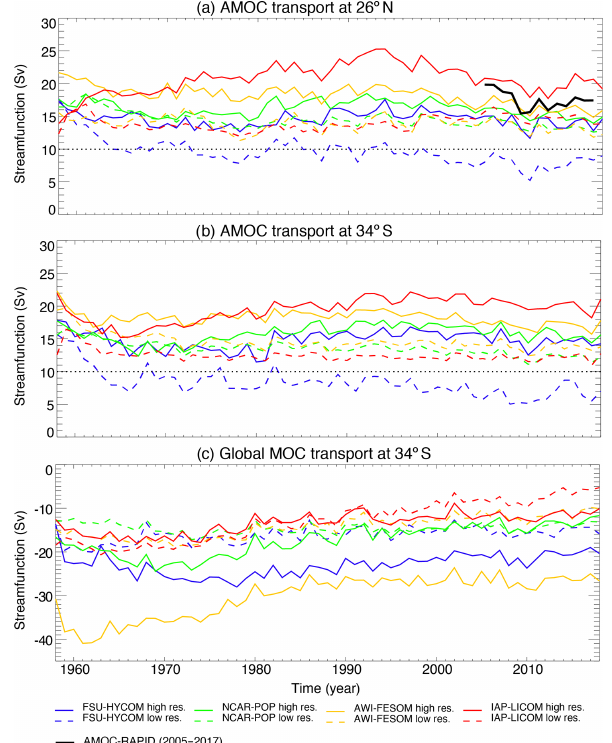
Figure 15. Modeled annual mean Atlantic meridional overturn- ing circulation (AMOC) transports at (a) 26.5 ◦ N and (b) 34 ◦ S; (c) global meridional overturning circulation (MOC) transports at 34 ◦ S. The global MOC transport is negative because the northward- flowing Antarctic Bottom Water (AABW) is below the southward return flow (see Lumpkin and Speer (2007) and Talley (2013) for observed values). The solid black line in panel (a) is derived from the RAPID array measurements (Smeed et al., 2018).